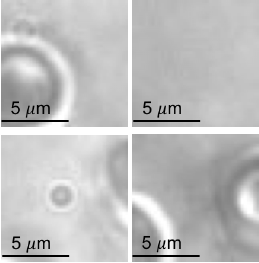
Figure 18. Examples of negative training samples for the convolutional neural